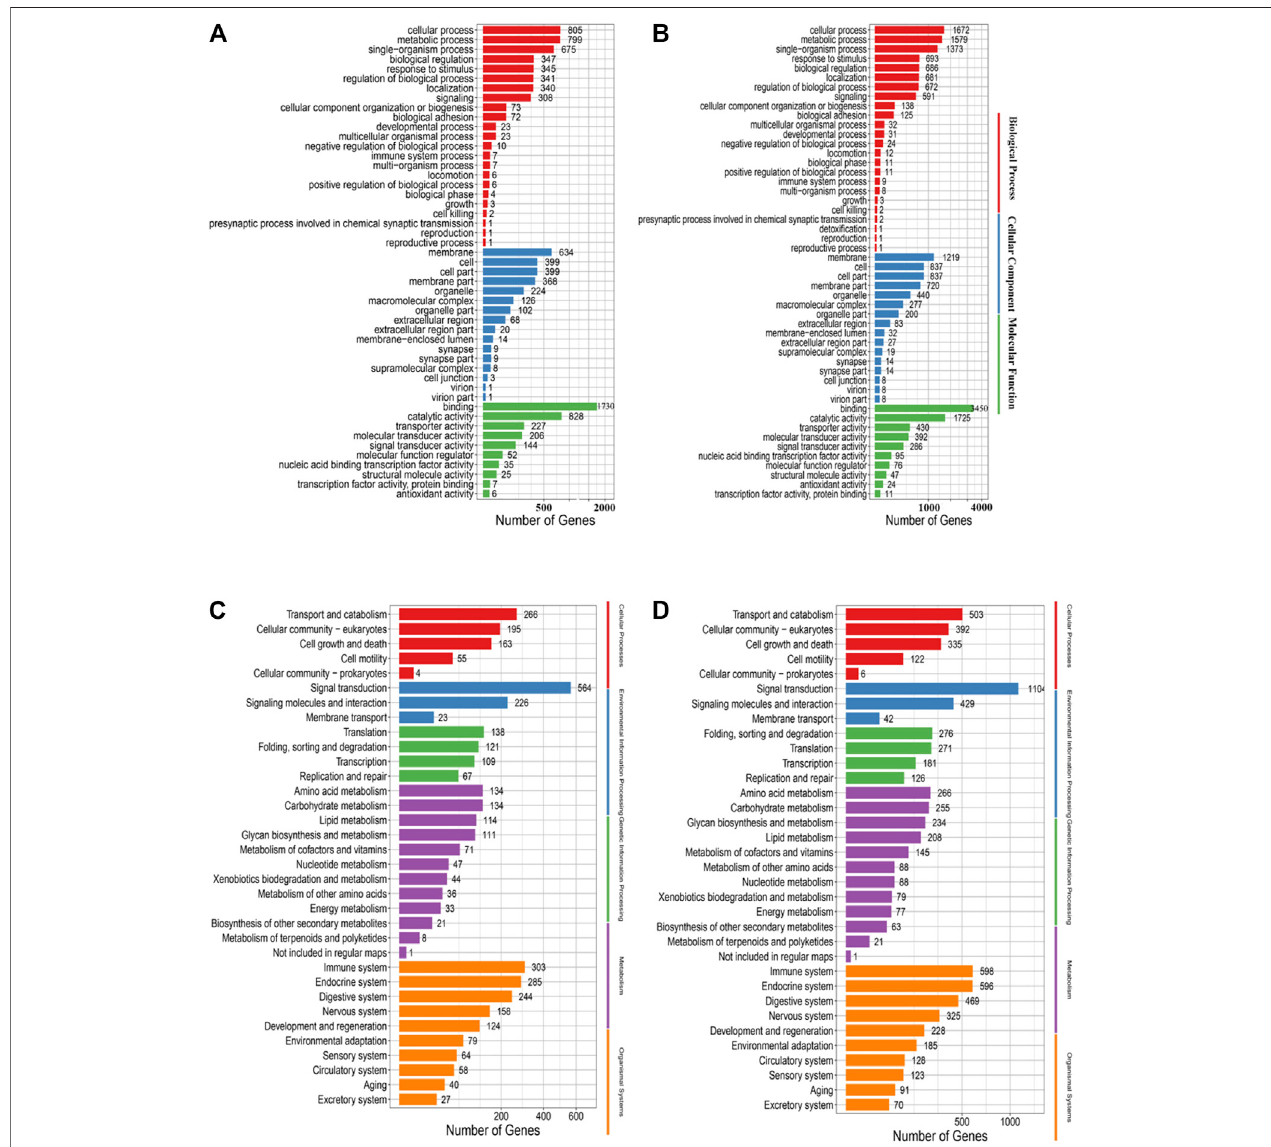
FIGURE5|(A) GOannotationanalysisofnonsynonymousSNPsinthecontrolgroup. (B) GOannotationanalysisofnonsynonymousSNPsinthetreatmentgroup. (C) KEGG enrichment analysis of nonsynonymous SNPs in the control group. (D) KEGG enrichment analysis of nonsynonymous SNPs in the treatment group.